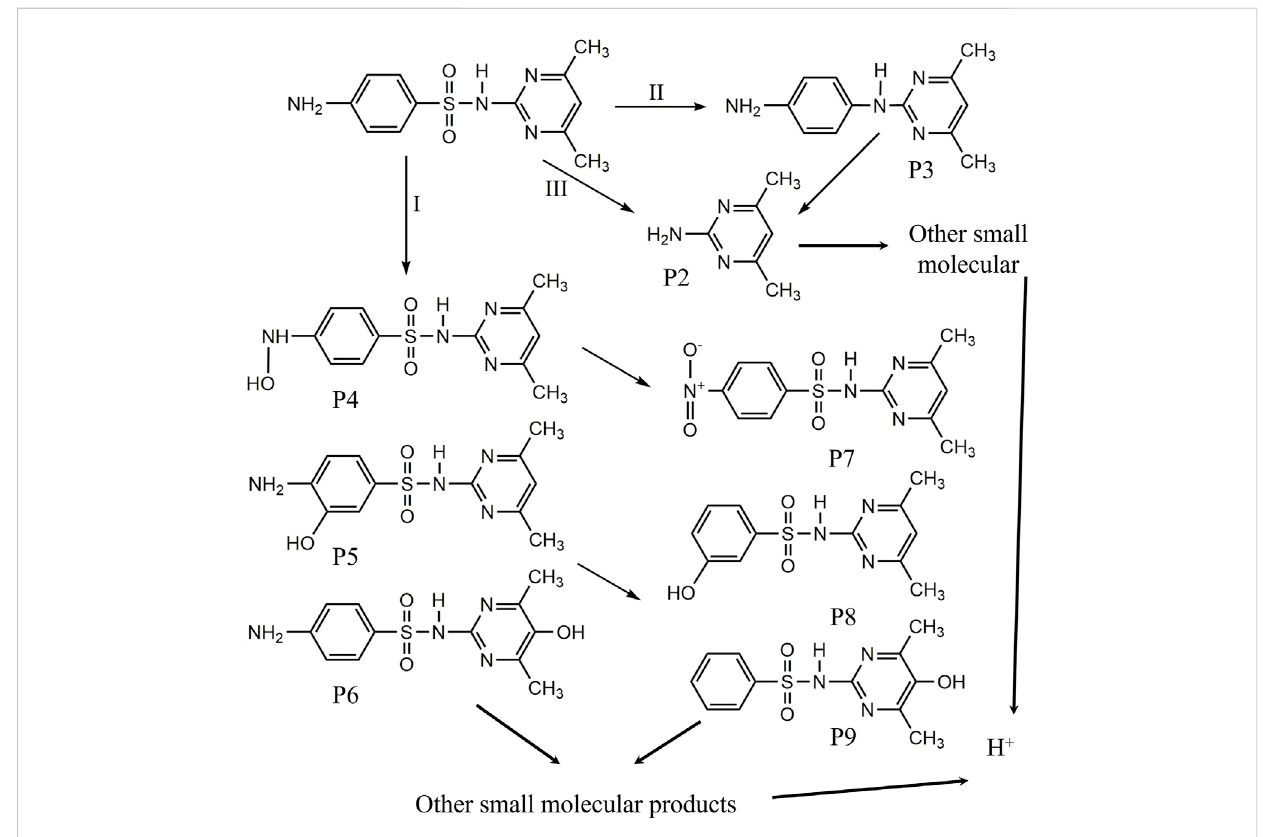
FIGURE 4 Degradation pathways of SMZ in the catalytic ozonation